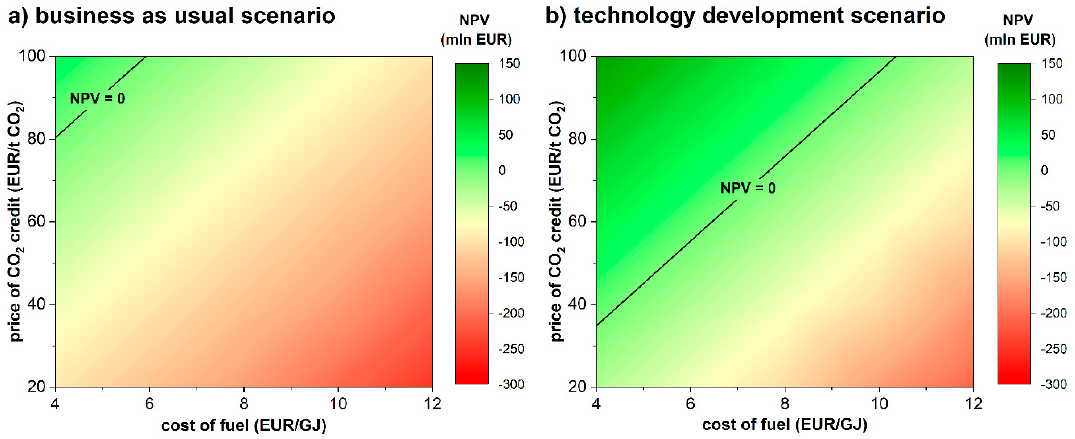
Figure 14. NPV in the function of negative CO 2 emission credits and the cost of fuel in ( a ) the business as usual scenario and ( b ) the technological development scenario.